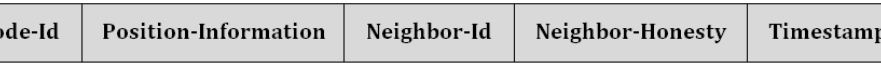
Figure 4. The Honesty beacon format in SecE-V2X.